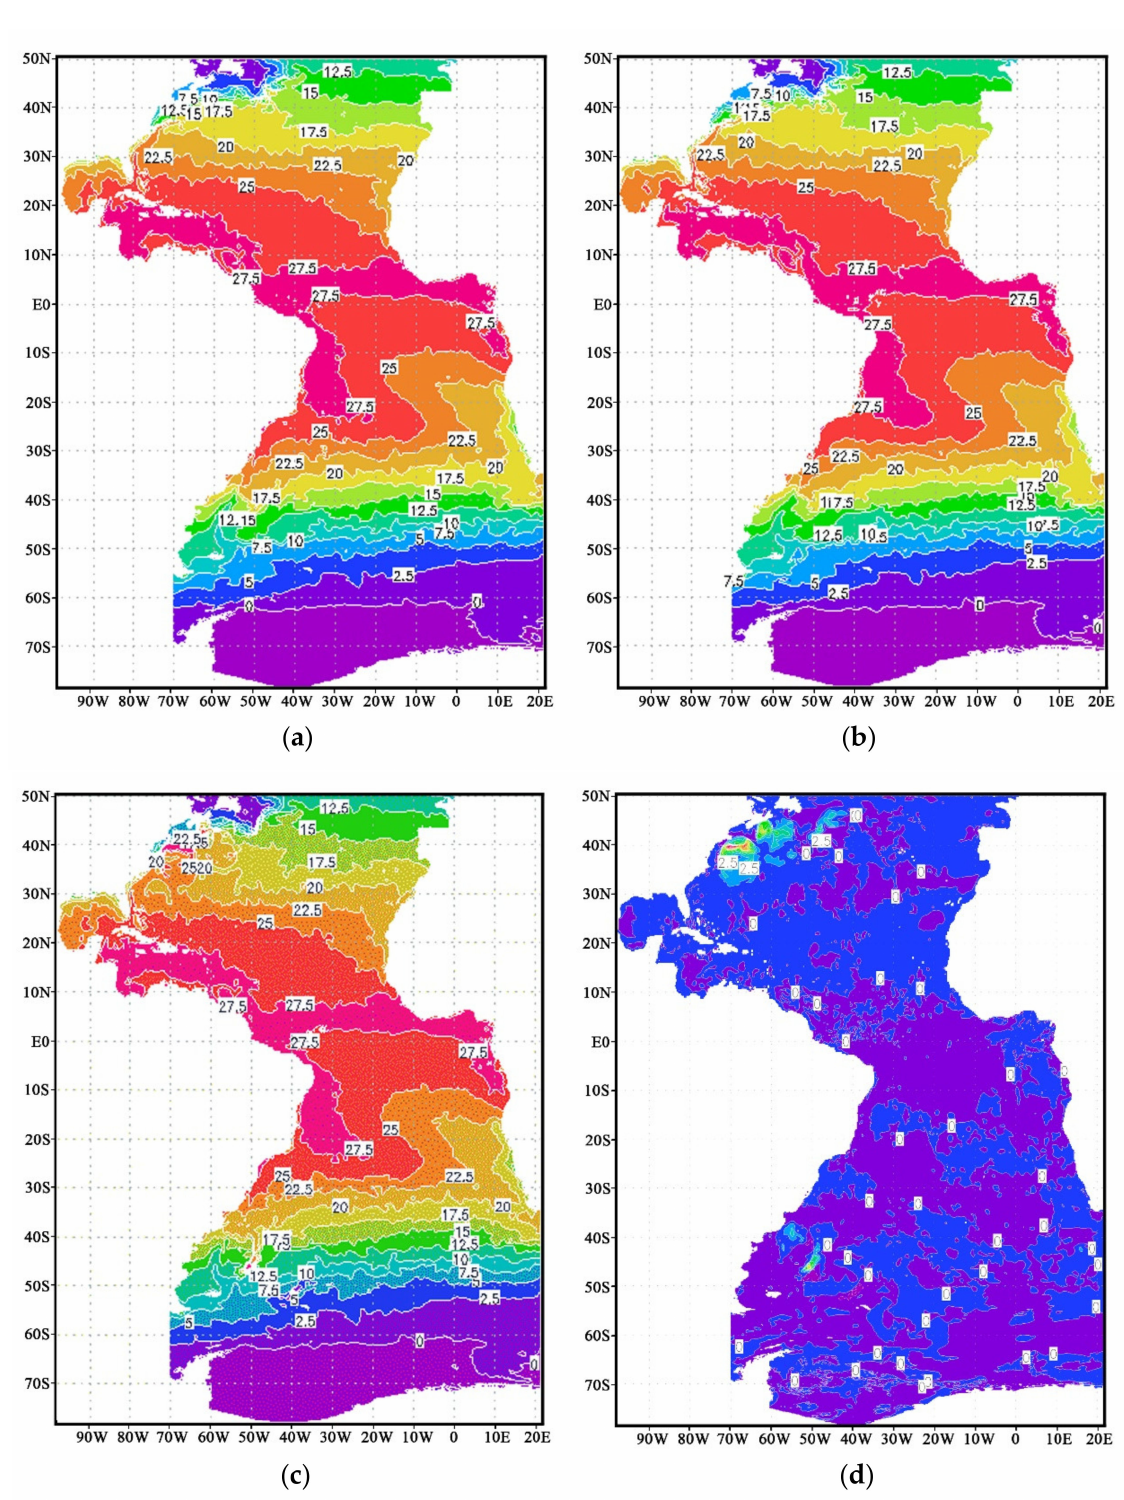
Figure 5. The results of calculation of SST ( ◦ C) on 27 January 2010: ( a ) control run; ( b ) assimilation by EnOI; ( c ) assimilation by GKF; ( d ) difference between the SST fields calculated by EnOI and GKF (EnOI minus GKF)